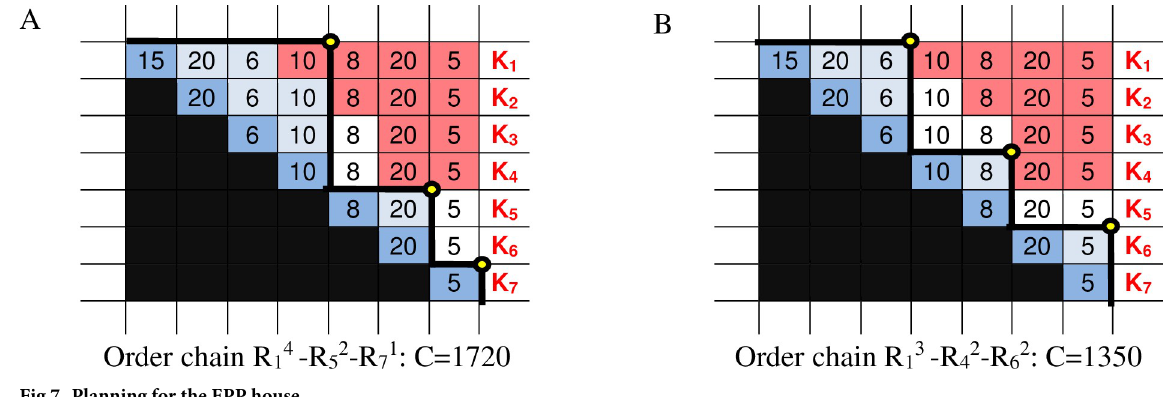
Fig 7. Planning for the EPP